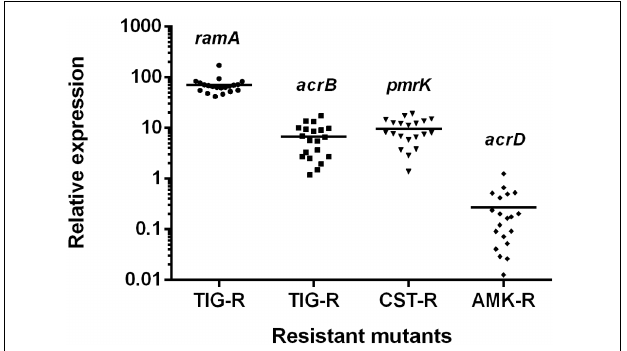
FIGURE 6 | Relative expression levels of ramA , acrB , pmrK, and acrD genes for resistant mutants of Kp3 recovered from the selection pressure of three different drugs. TIG-R, tigecycline-resistant mutants; CST-R, colistin-resistant mutants; AMK-R, amikacin-resistant mutants.